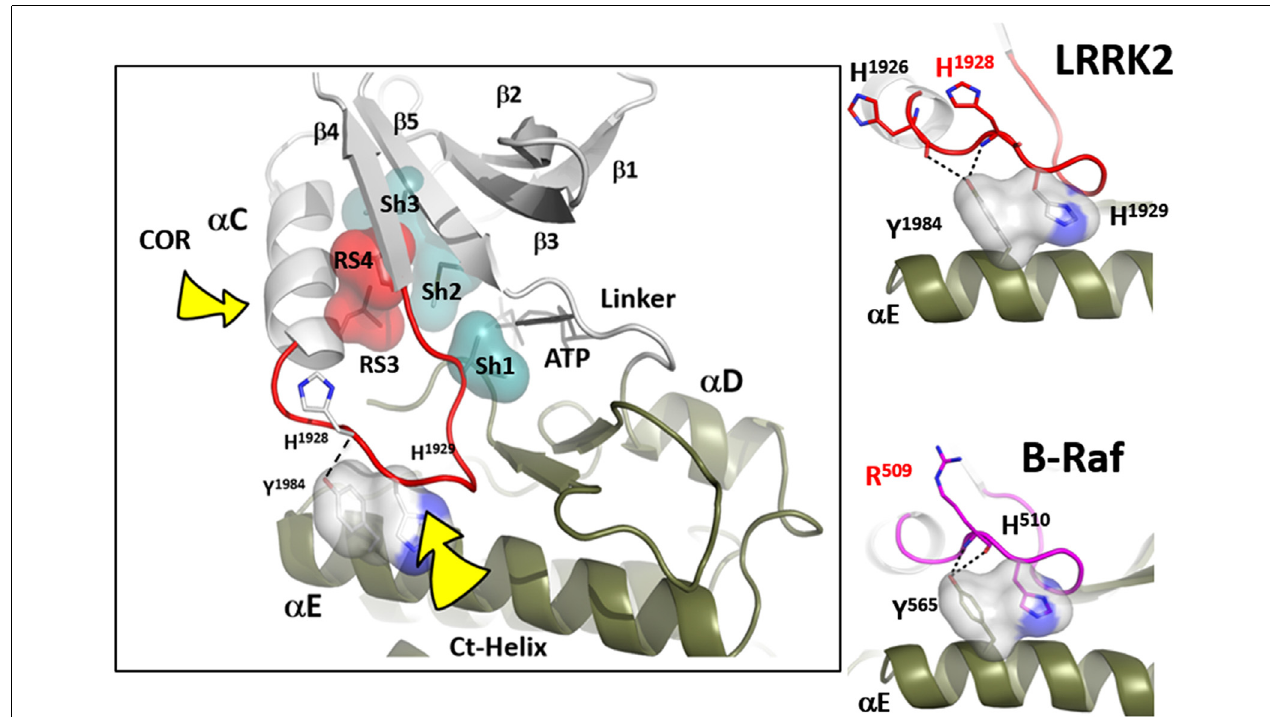
FIGURE 3 | The α C- β 4 loop of LRRK2. The highly conserved α C- β 4 loop of LRRK2 is indicated in red. The two hydrophobic R-spine residues are shown as a red transparent surface while the Sh1 residue that touches the adenine ring of ATP is in teal. Sh2 and Sh3 also in teal serve as a further hydrophobic bridge. RS3 (L1924) is at the N-terminus of the α C- β 4 Lop while the C-terminus is the RS4 (L1935) residue. In the active conformation RS3 and RS4 are aligned with RS1 and RS2 in the C-Lobe. RS4 is always firmly anchored to the β -sheet while RS3 lies at the C-terminus of the aC-Helix which can flip “in” and “out.” The two right panels show how the α C- β 4 Loop is anchored to the α